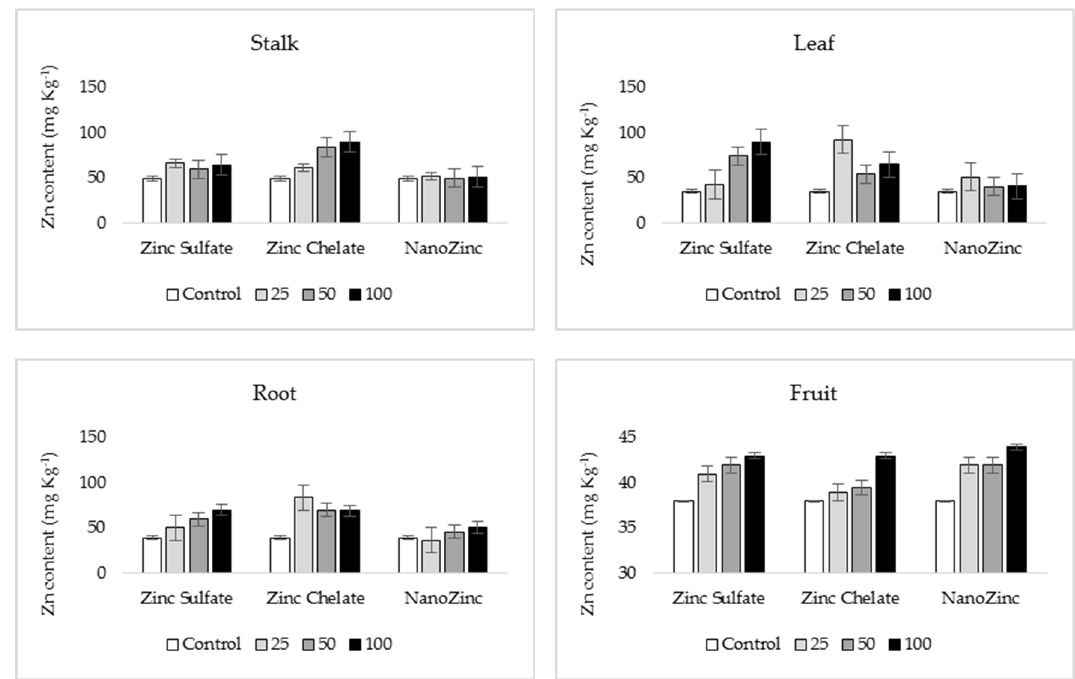
Figure 7. Zinc concentration in the root, stalk, leaf, and fruit of green beans cv. Strike in response to the application of nanofertilizers, chelates, and zinc sulfates.